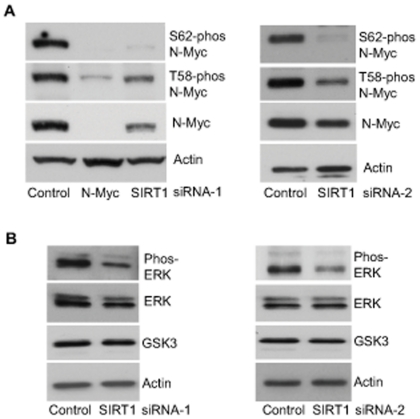
SIRT1 stabilizes N-Myc protein by promoting ERK protein phosphorylation and N-Myc protein phosphorylation at S62.(A, B) BE(2)-C cells were transfected with scrambled control siRNA, SIRT1 siRNA-1 (left panel) or SIRT1 siRNA-2 (right panel), followed by protein extraction. (A) Expression of total N-Myc protein, N-Myc protein phosphorylated at S62 (S62-phos) and N-Myc protein phosphorylated at T58 (T58-phos) was analysed by immunoblot with specific antibodies. (B) Expression of GSK3 protein, total ERK protein and phosphorylated ERK protein (phos-ERK) was analysed by immunoblot with specific antibodies.